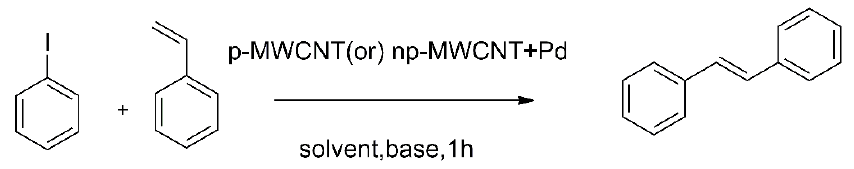
Scheme 1. General representation of reaction.